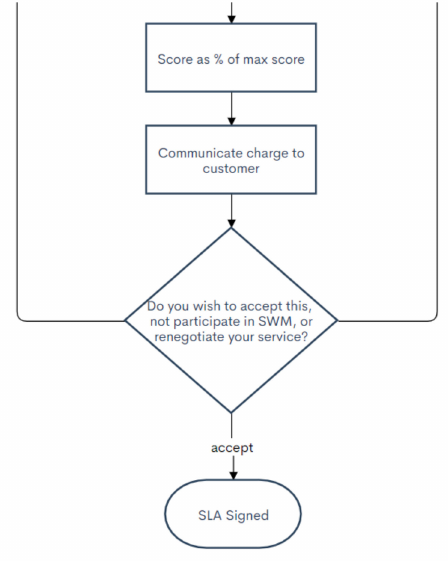
Figure 5. Third phase of assigning a customer